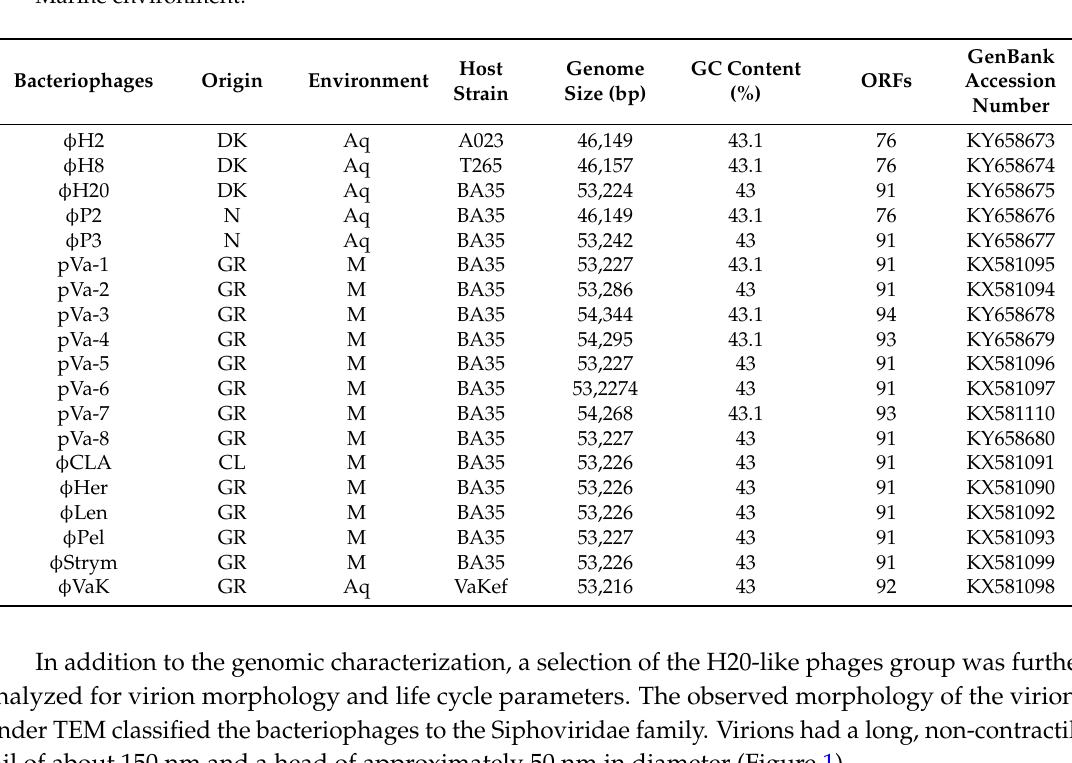
Table 1. Genomic information about the 19 sequenced bacteriophages of the current study. The bacteriophages were isolated against four different clinical Vibrio anguillarum strains (A023, T265, BA35, and VaKef). DK: Denmark, N: Norway, GR: Greece, CL: Chile, Aq: Aquaculture. M: Marine environment.